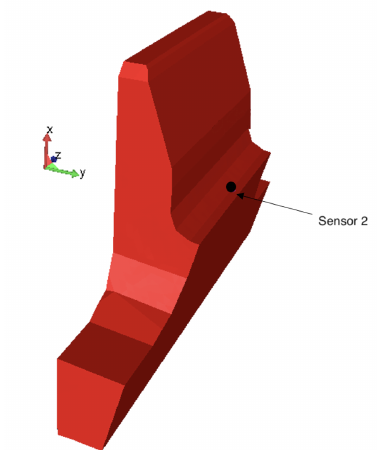
Figure 9. Location of sensor 2 in the gear.